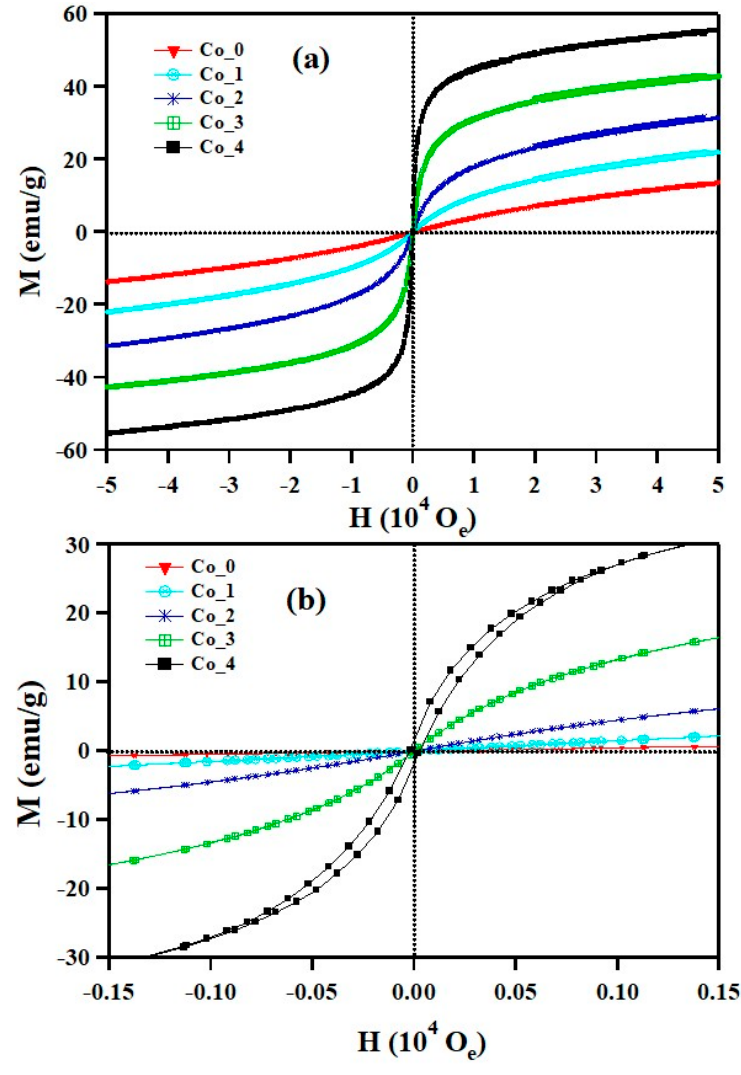
Figure 6. ( a ) Room temperature (300 K) magnetization-field (M-H) hysteresis loops of Co x Zn 1-x Fe 2 O 4 ferrite systems; ( b ) the magnification of the central area of the hysteresis loops.